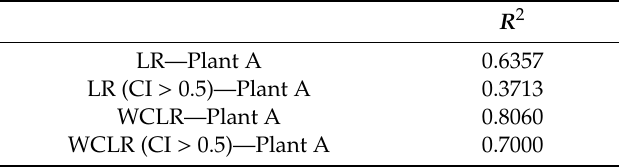
Table 4. Correlation coe ffi cient values of LR, LR (CI > 0.5), WCLR, WCLR (CI > 0.5)—Plant A.